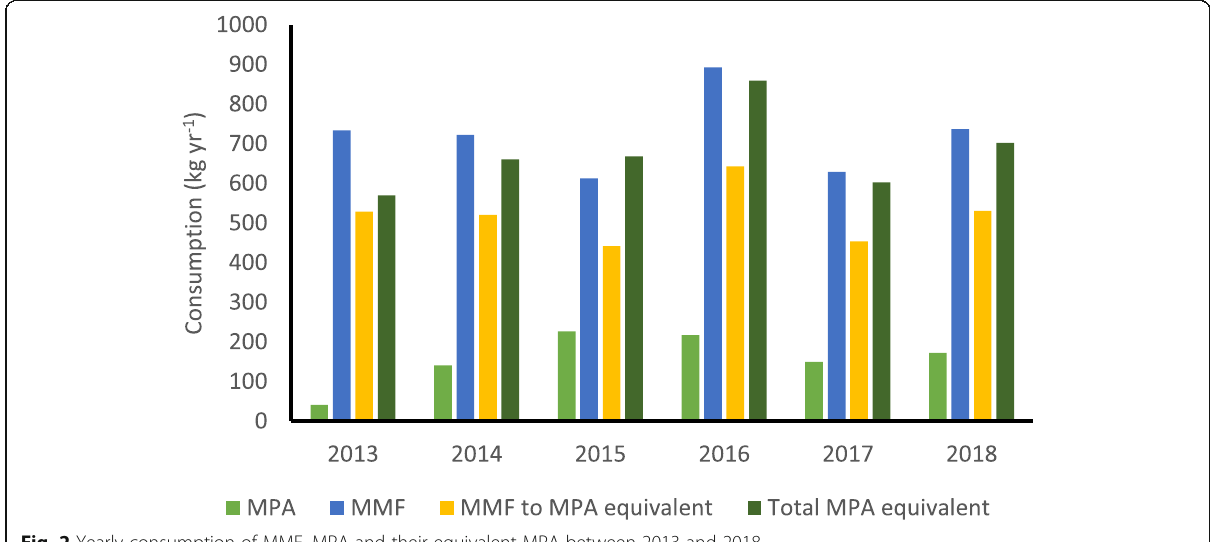
Fig. 2 Yearly consumption of MMF, MPA and their equivalent MPA between 2013 and